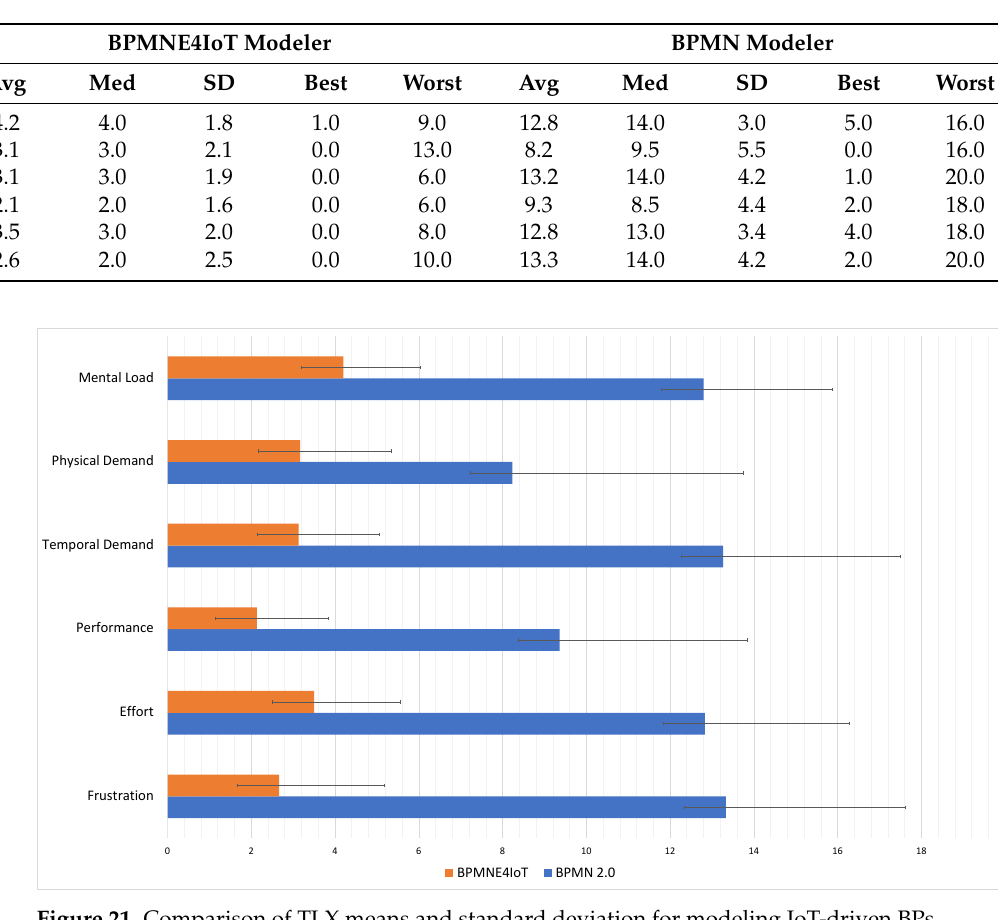
Table 6. Results of the NASA-TLX questionnaire.